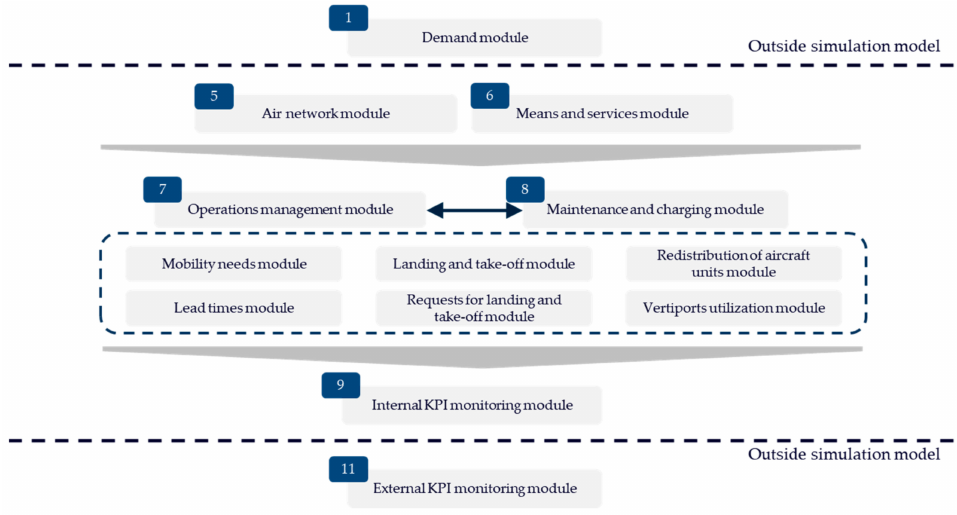
Figure 13. Simulation